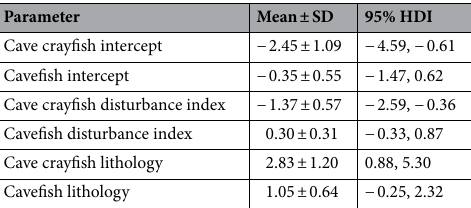
Table 1. Estimated occurrence probability of cavefishes and cave crayfishes while accounting for imperfect detection derived from an occupancy model. HDI highest density interval.